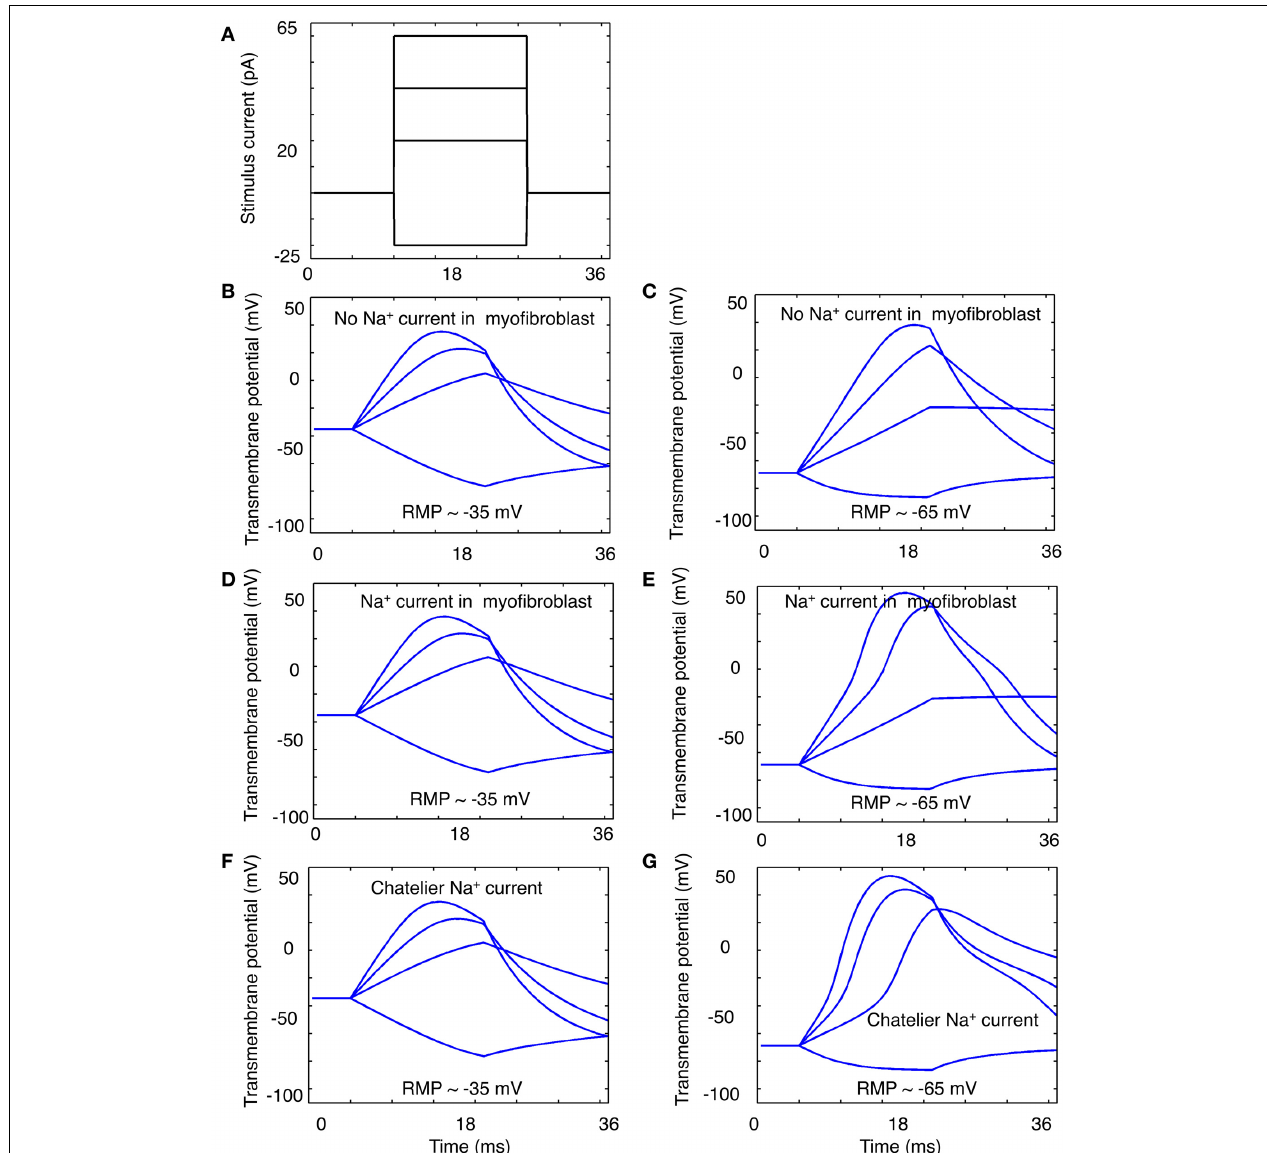
responses in (D,E) were obtained when this model also included equations for the Na + current in this paper; or the Na + current in the Chatelier et al. paper (2012) (F,G) . Note when Na + current is included, most of the depolarizing stimuli produce a biphasic response. This may suggest a contribution of Na + current activation to the stimulus-induced depolarization (see